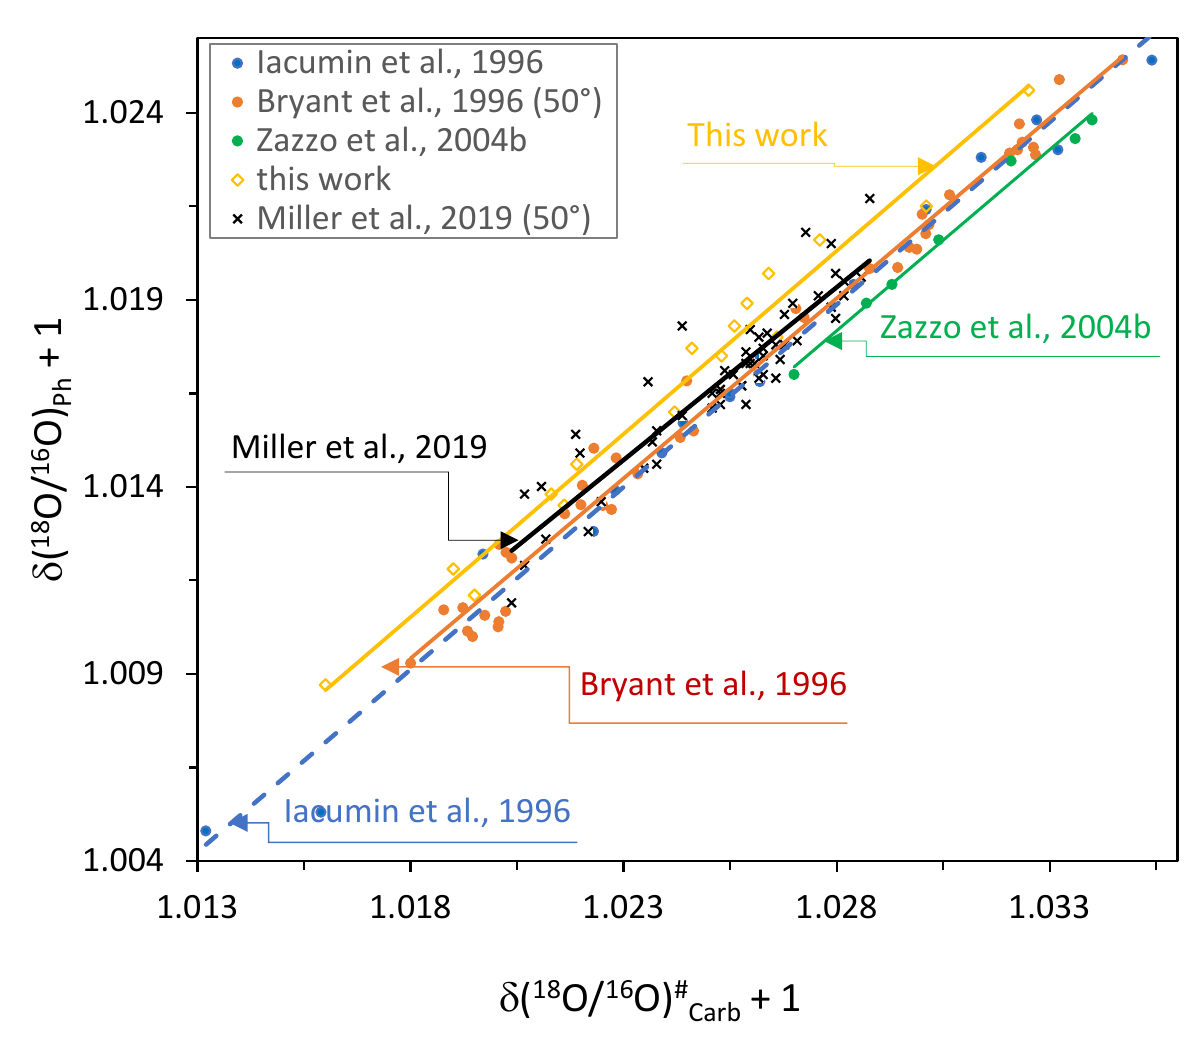
(cid:0) 18 (cid:1) # Figure 1. δ( O 18 / O 16 ) Ph + 1 on (δ / O 16 ) Carb#18 + 1. The regression lines have the same slope but dif- 309 Figure 1. δ O/ 16 O + 1 on ( δ 18 / 16 O ) + 1. The regression lines have the same slope but Carb Ph different elevations ferent elevations [20,21,56,57].